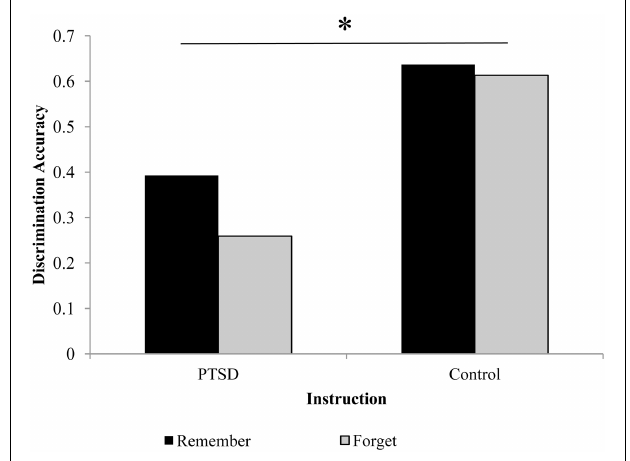
FIGURE 2 | Discrimination accuracy for the remember (R) and forget (F) conditions in the PTSD and control group illustrating both the group difference in recognition accuracy and the directed forgetting pattern